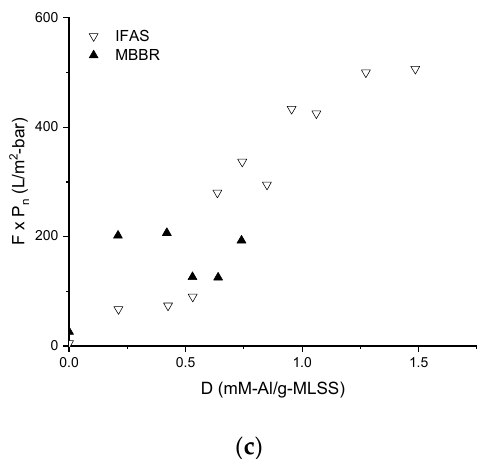
Figure 3. Influence of the chemical enhancer dose on filtration duration F ( a ), membrane permeability P n ( b ) and their product F × P n ( c ) during filtration of Mixed Liquors from MBBR and IFAS.